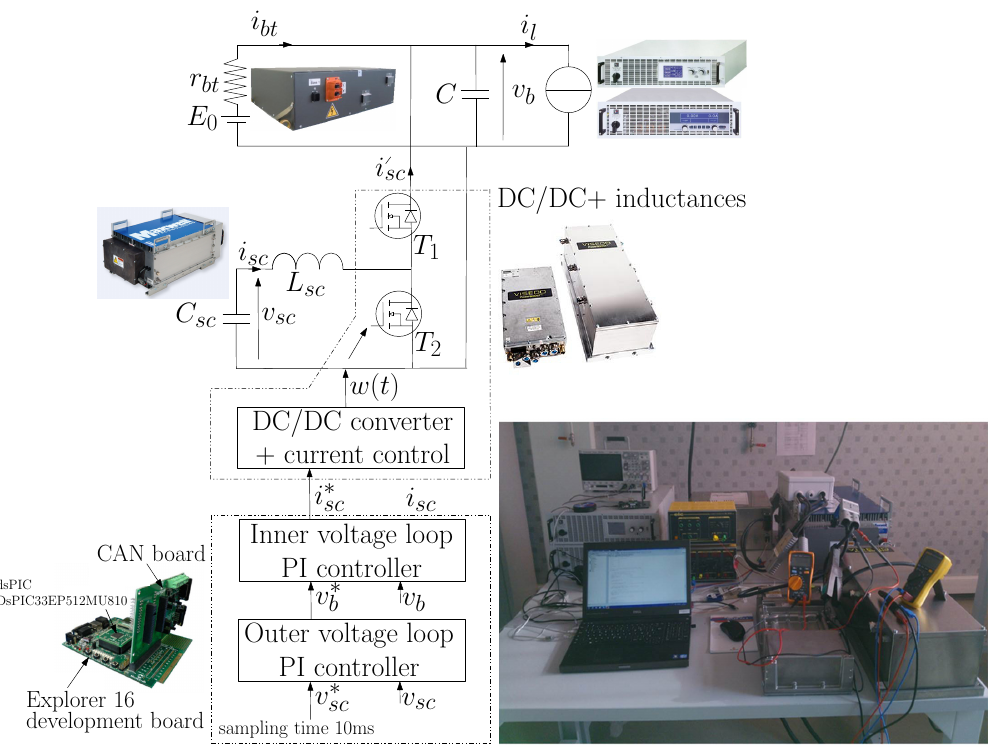
Figure 1. Experimental setup and regular controller of a one-converter hybrid